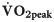
Correlation between V˙O2peak and mean of daily steps. No statistically significant correlation could be detected.